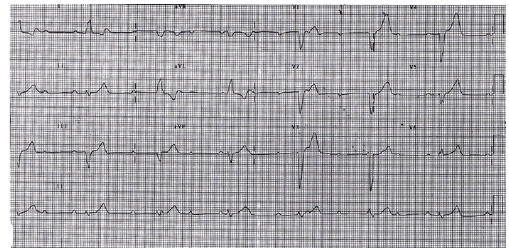
Figure 3: Electrocardiogram showing complete heart block (CHB). Ventricular rate is 25 per minute and QRS complex is very wide and there is AV dissociation.